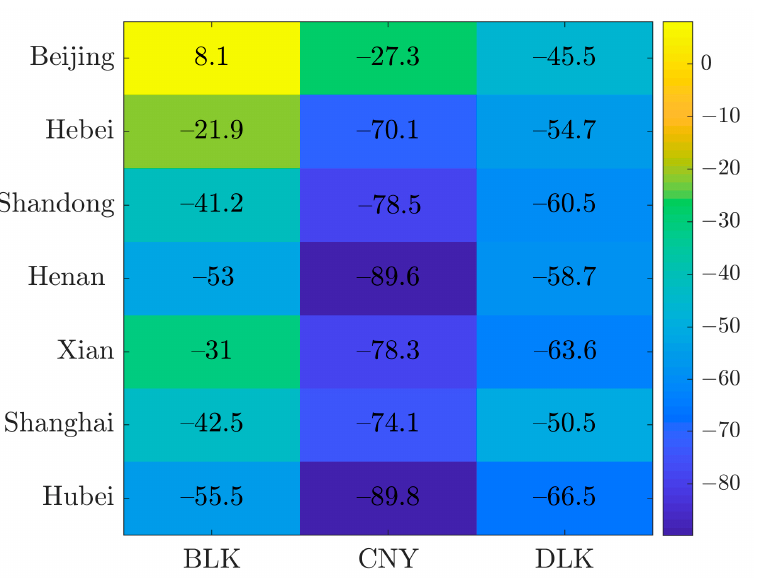
Figure 5. Percentage change (%) in satellite-derived tropospheric NO 2 for three consecutive periods in early 2020 (BLK, CNY and DLK) for seven regions across China, as compared with equivalent periods in the reference year 2019.